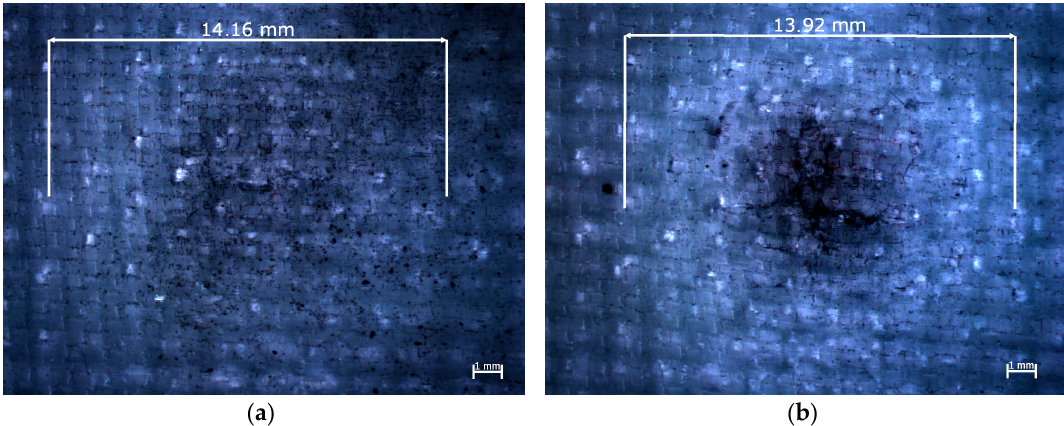
Figure 8. Epoxy composites reinforced by Dyneema SK 60 fibers after impact from: ( a ) conical striker, ( b ) ogival striker—view from the opposite side to the impact side.